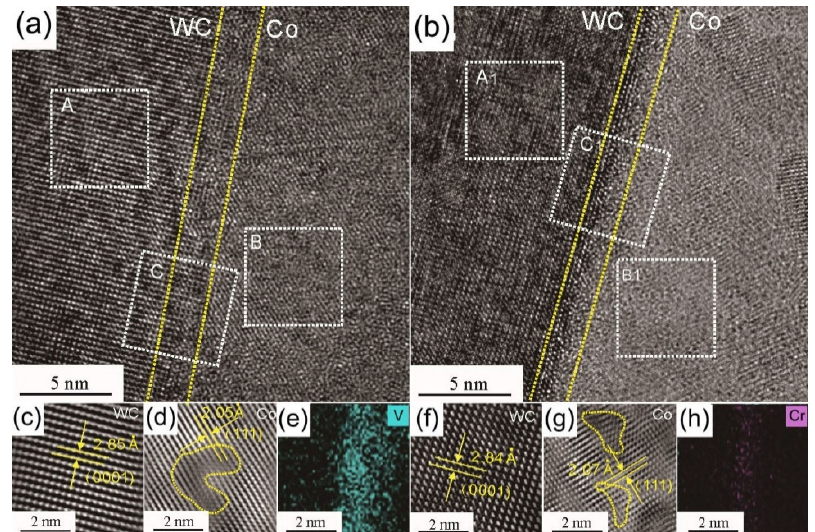
Figure 6. HRTEM images of the WC/Co interface areas doped with V and Cr. ( a ) WC–6Co–0.6VC; ( b ) WC–6Co–0.6Cr 3 C 2 ; ( c ) FFT of region A; ( d ) FFT of region B; ( e ) HREDX result of region C; ( f ) FFT of region A1; ( g ) FFT of region B1; ( h ) HREDX result of region C1.